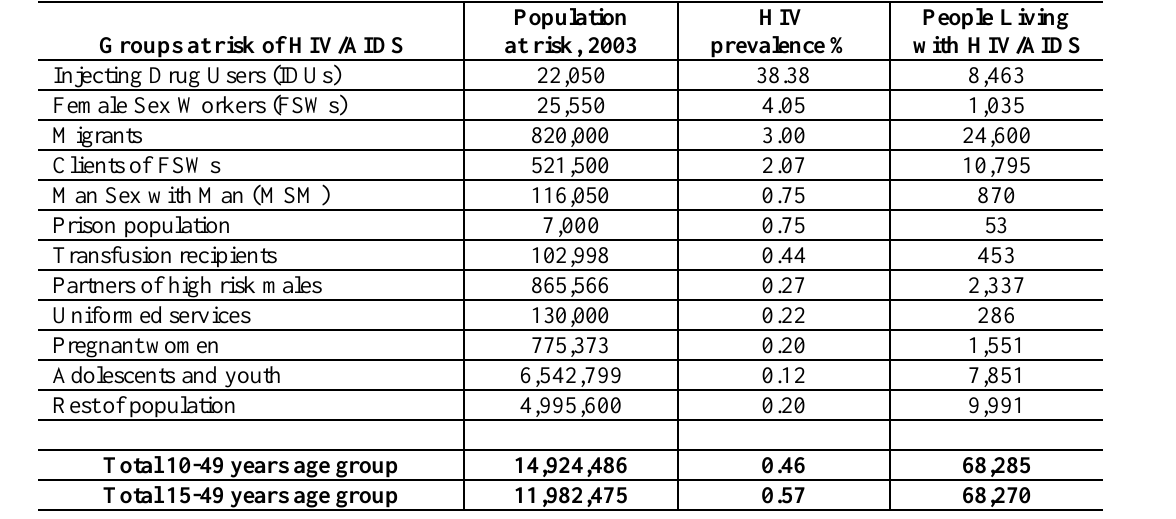
Table IV : Estimates of population at risk (15-49) and People Living with HIV/AIDS, 2003,